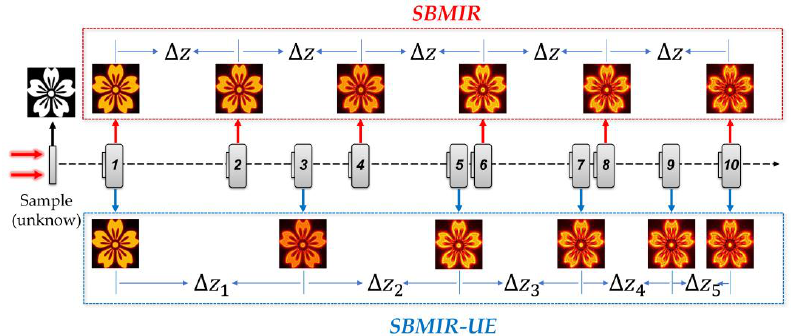
Figure 5. The experimental recording processes.